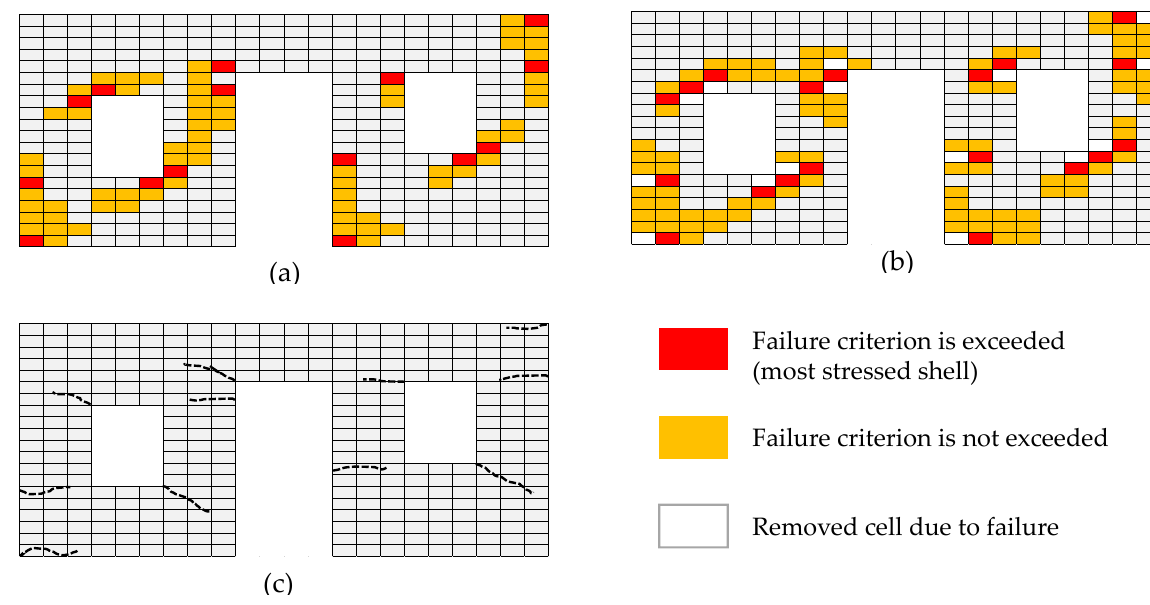
Figure 11. ( a ) Initial stress states at ultimate condition (left), ( b ) first step of crack propagation after removal of overstressed cells (middle), ( c ) the final crack pattern of the considered URM wall (right) [32].